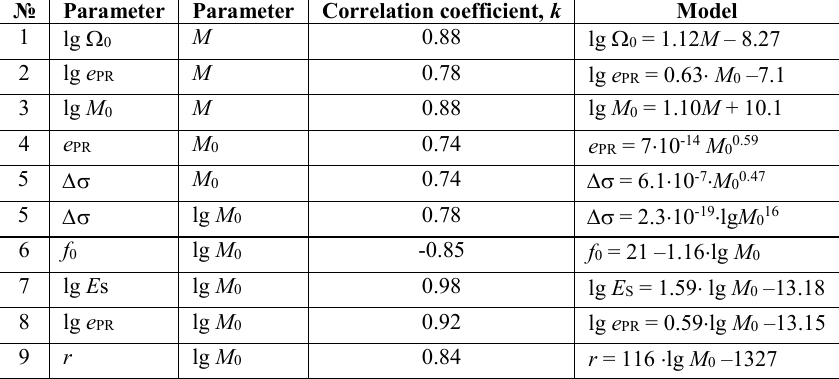
Table. 3. Regression dependences and correlation coefficients of dynamic parameters of earthquake sources and their magnitude and seismic moment.